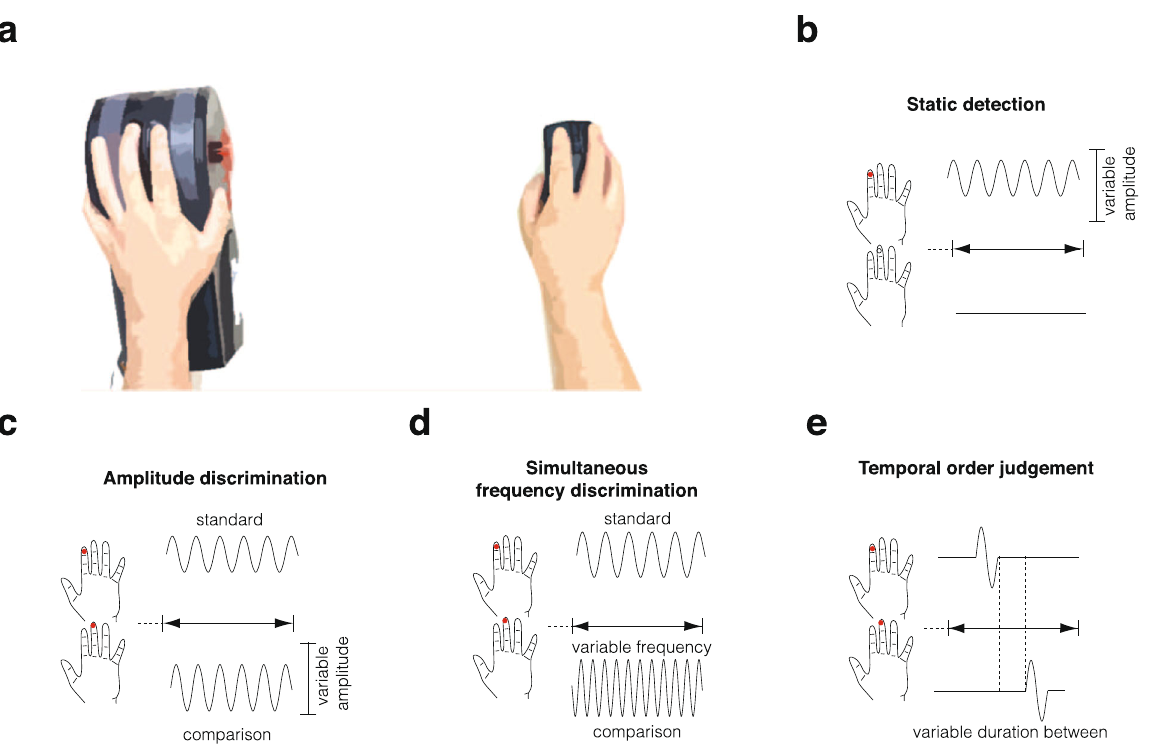
Fig. 1 Overview of the setup and completed protocols. a Participants placed their left hand on the vibrotactile stimulator and their right hand on a computer mouse. The stimulator delivered sinusoidal pulses to the left digit 2 and 3 via two 5 mm cylindrical probes. Responses were made with right digits 2 and 3 All stimuli were delivered between 0 – 350 μ m and between 0 – 50 Hz. b Visual schematic of the static detection protocol. A single tactile